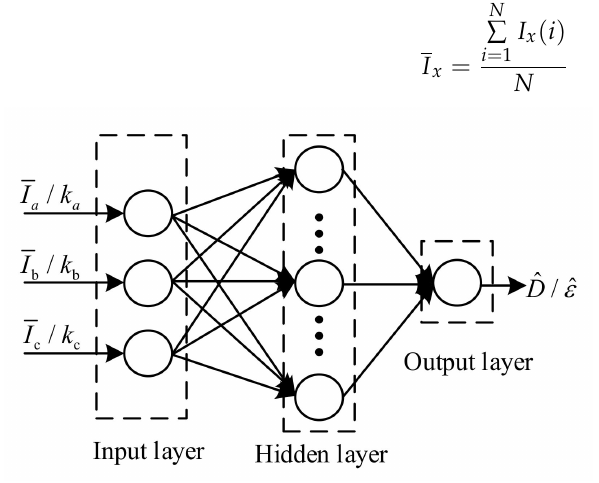
Figure 5. Estimation of ε x , D x based on BP neural